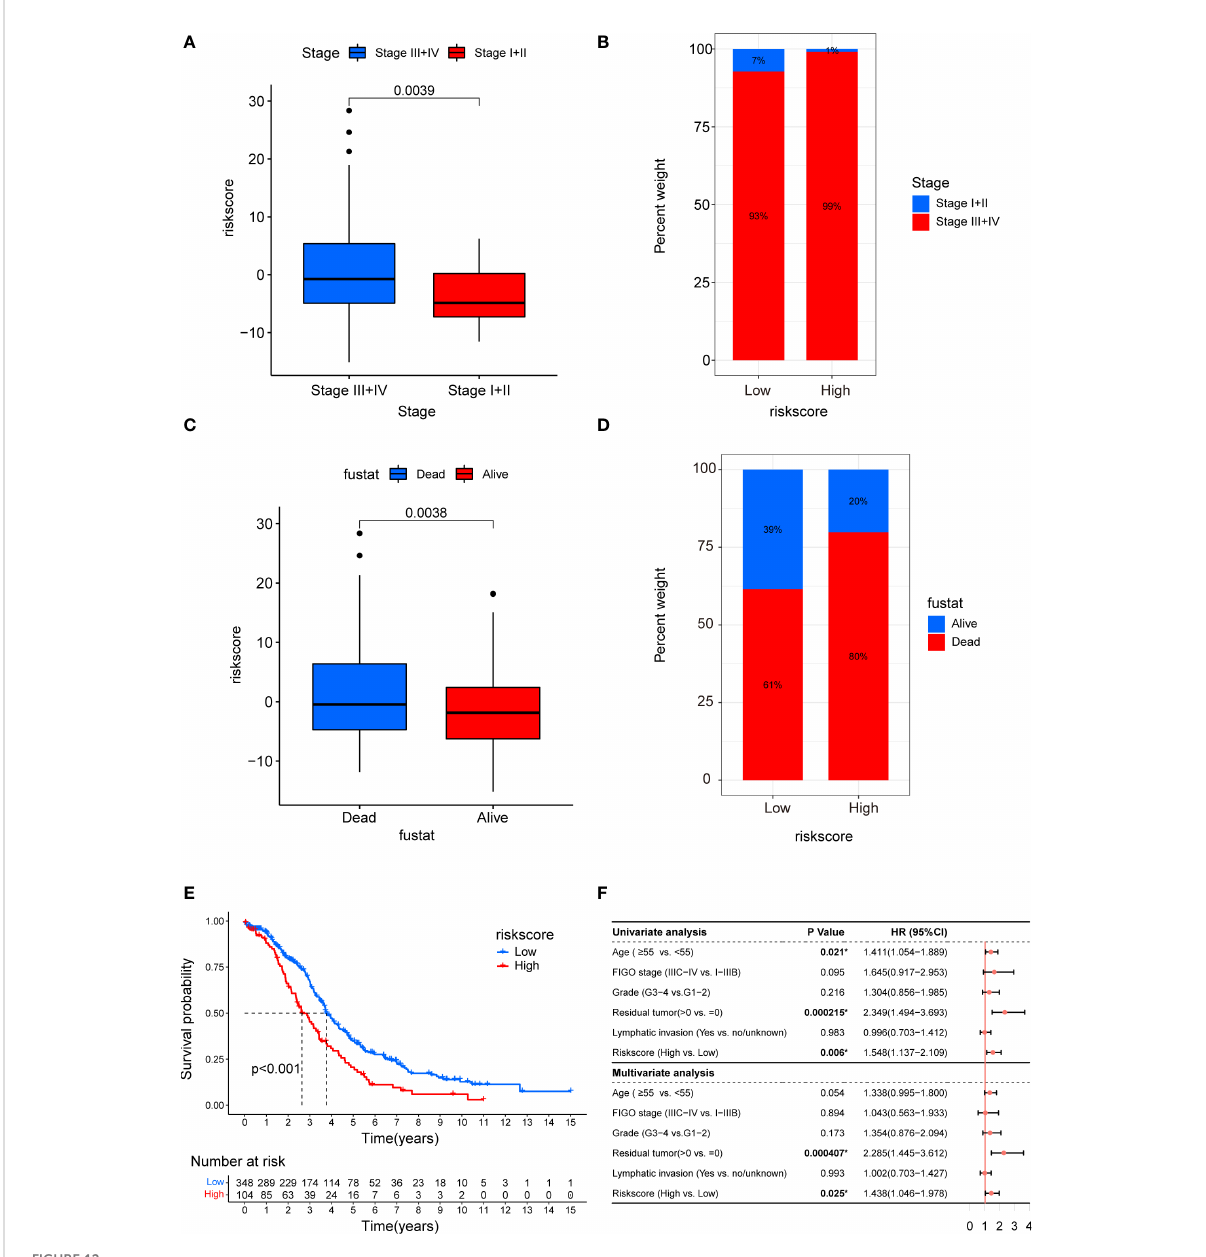
FIGURE 12 Clinicopathological and prognostic characteristics of CAF riskscore. (A) Correction between CAF riskscore and tumor stage. (B) Proportions of tumor stage in high- and low-riskscore groups. (C) Correction between CAF riskscore and survival status. (D) Proportions of survival status in high- and low-riskscore groups. (E) Kaplan – Meier curves of overall survival between high- and low-riskscore groups. (F) Forest map of CAF riskscore and clinicopathological parameters in TCGA_OV